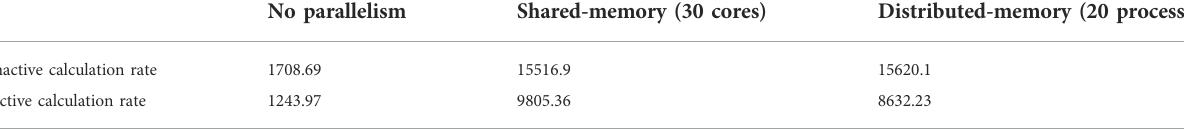
TABLE 1 OpenMC calculation speeds with different parallelism models (Unit: